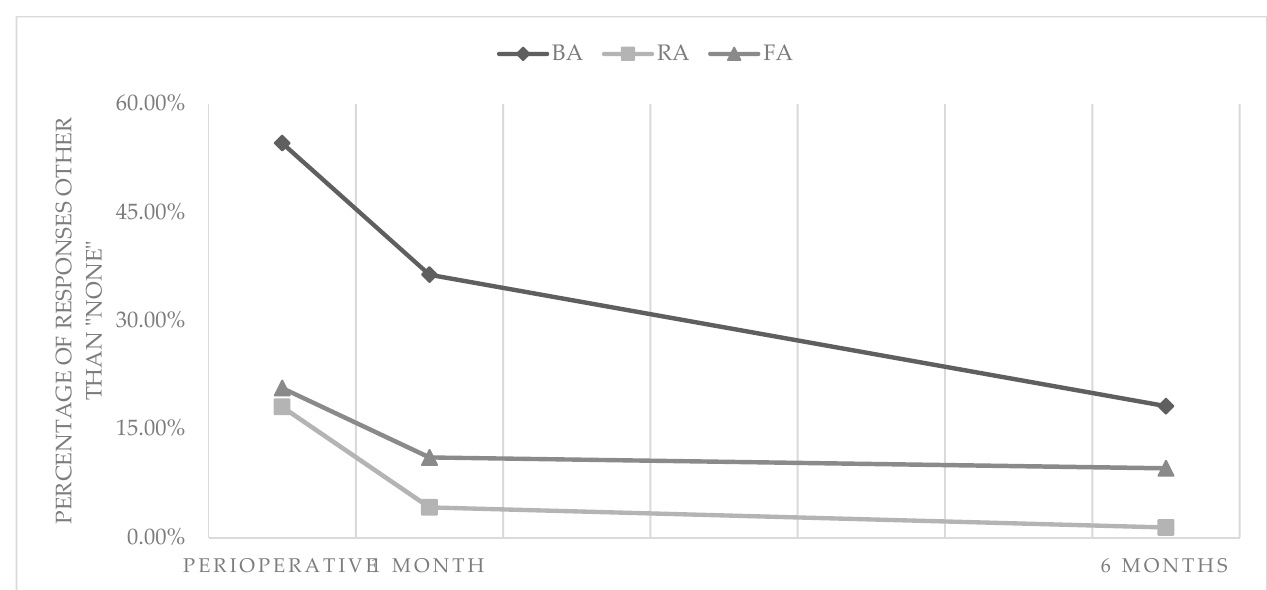
Figure 2. Percentages of responses other than "none" to the question from the EQ-5D-3L questionnaire regarding problems with self-care and their change over time.